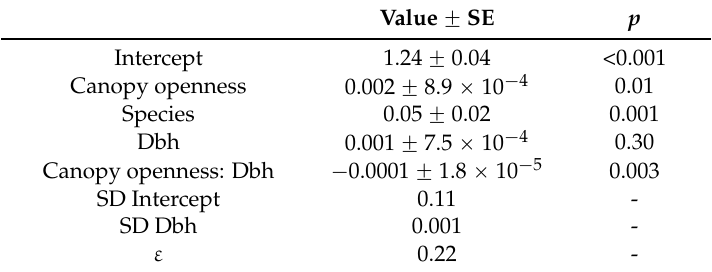
Table 5. Linear mixed model on ring width index (RWI) development of all years with an index > 1 (growth higher than normal, favorable years) of all analyzed trees as the response variable with the individual tree code as a random effect and a random slope added for the effect of dbh, and fixed effects canopy openness, analyzed species, and dbh of the form: RWI ij = β 1 ˆ x 1 ij + . . . + β n ˆ x